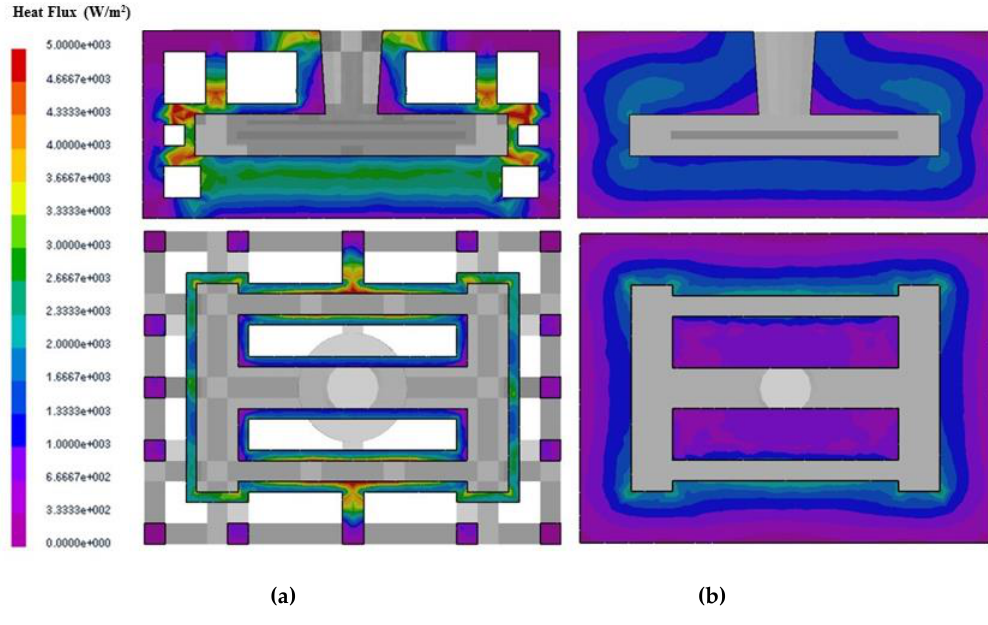
Figure 11. Comparison of heat flux of (a) skeletal and (b) traditional sand molds at 2500 s.